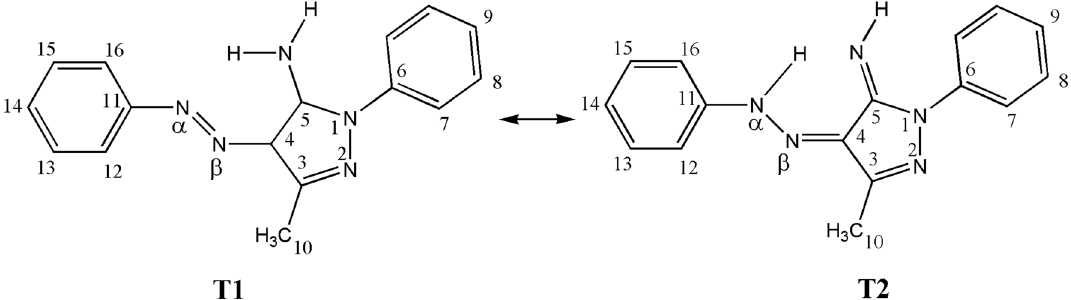
Figure 1. Chemical structure of 3-methyl-1-phenyl-4-(phenyldiazenyl)-1H-pyrazol-5-amine ( T1 ) and its tautomer ( T2 ) in 1 H- and 13 C-NMR